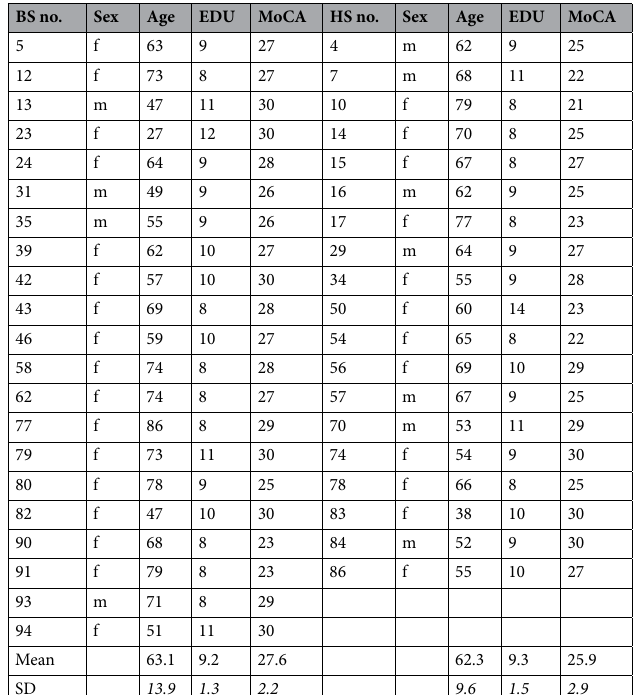
Table 3. Demographic data of blepharospasm and hemifacial spasm patients. BS: blepharospasm, No.: number, EDU: educational level (in school years), HS: hemifacial spasm, MoCA: Montreal Cognitive Assessment, f: female, m: male, SD: standard deviation.